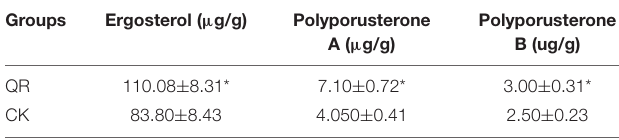
TABLE 2 | The content of ergosterol, polyporusterone A and